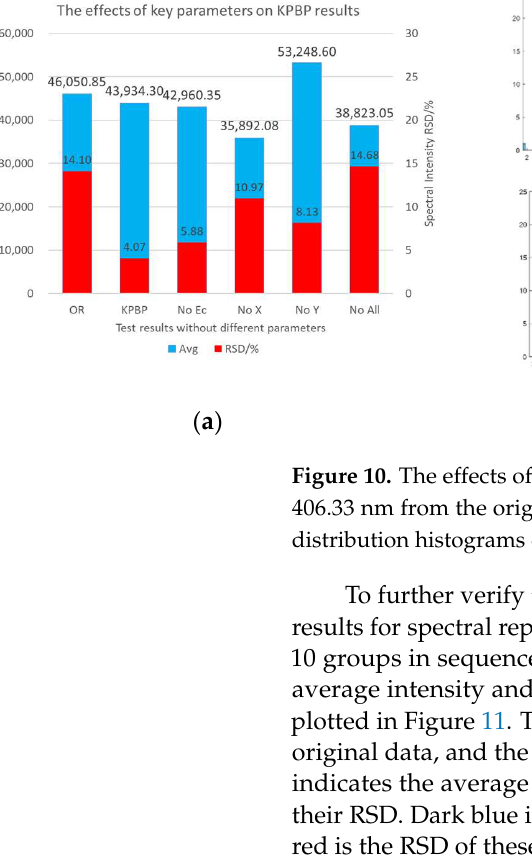
Figure 10. The effects of key parameters on KPBP results. ( a ) The average intensity and RSD of Fe 406.33 nm from the original spectra and the results of the experiments. ( b ) Fe 406.33 nm intensity distribution histograms of the original spectra and the results of the experiments.